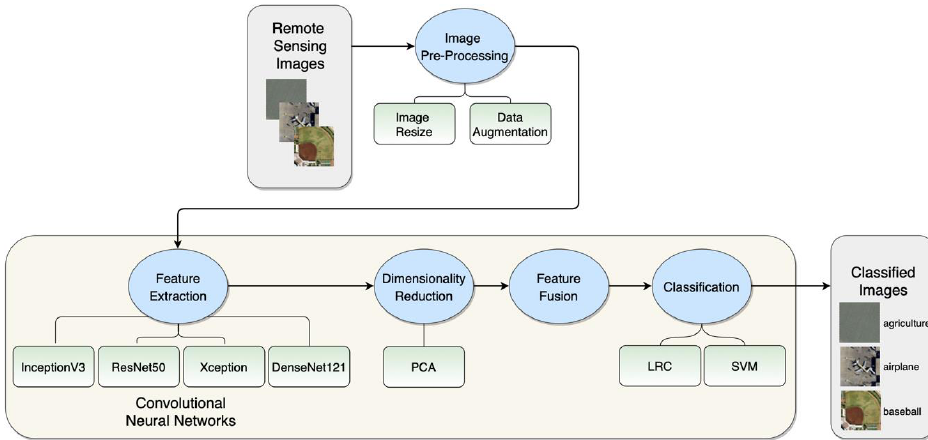
Figure 1. Workflow of the proposed method.